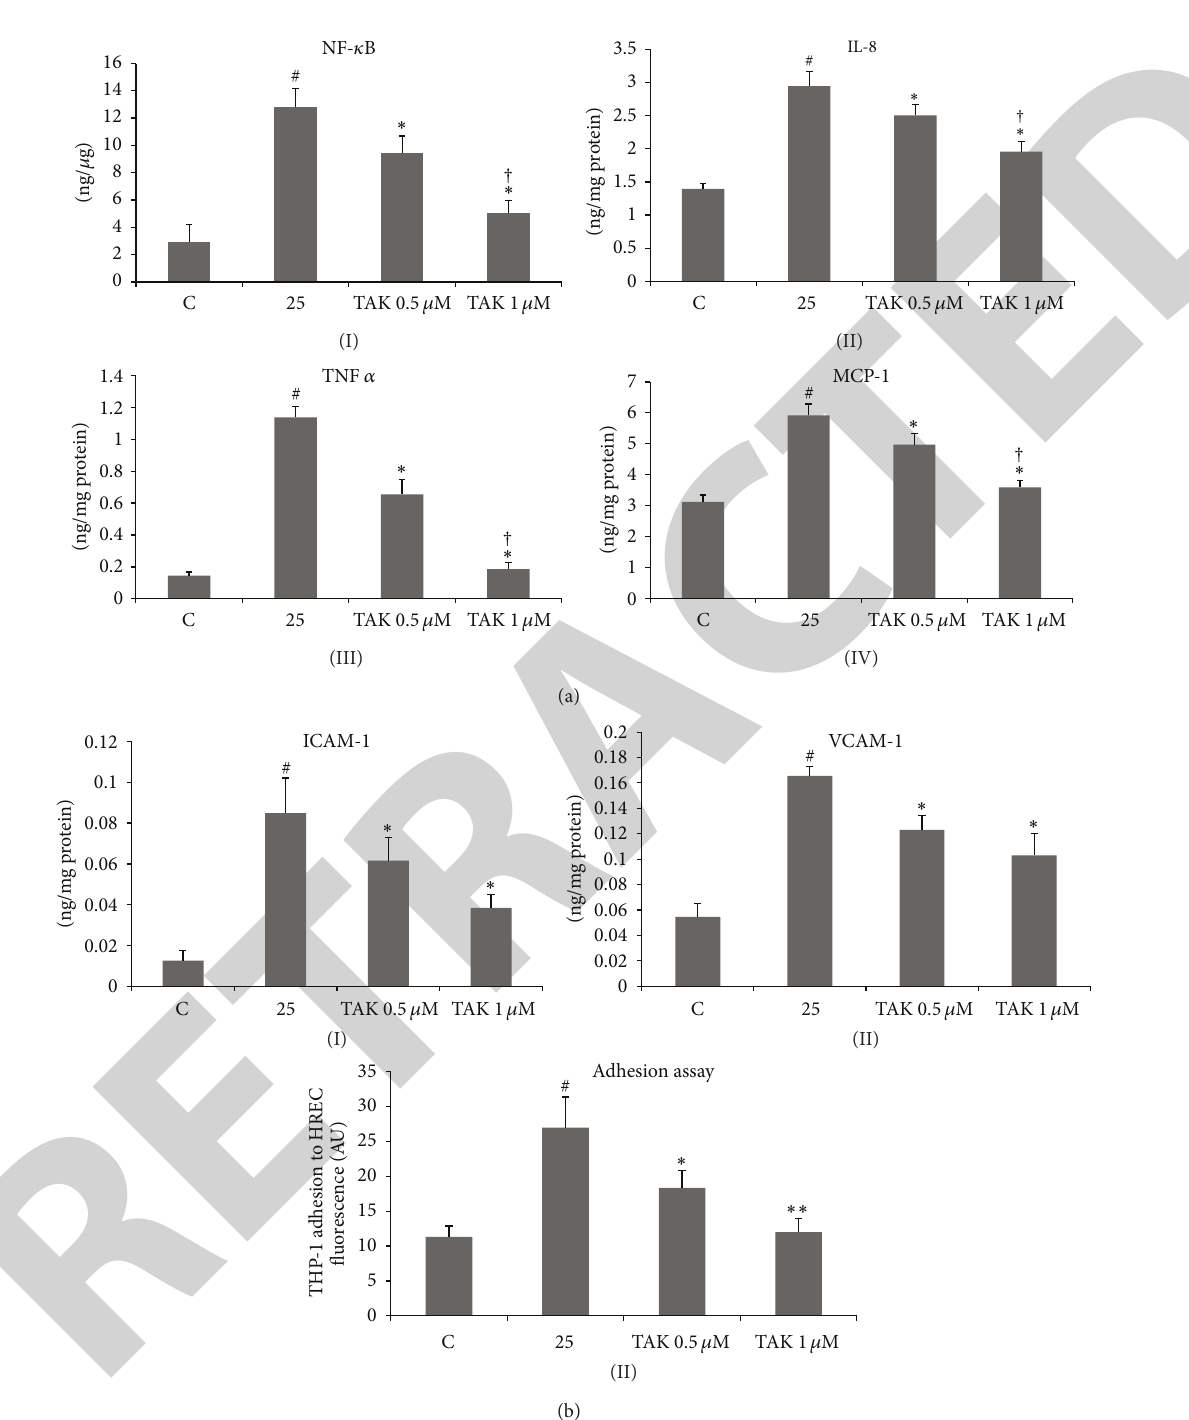
Figure 5: (a) TLR-4 inhibition by TAK 242 attenuates downstream inflammatory biomediators: HMVRECs were serum starved for 2 hours and treated with 0.5 and 1 𝜇 M TAK-242 for 2 hours. Thereafter 5.5 and 25 mM glucose treatments were performed as described in Figure 3. (I) NF- 𝜅 B, (II) IL-8, (III) TNF- 𝛼 , and (IV) MCP-1 levels are significantly decreased upon TLR-4 inhibition compared to HG treatment. # 𝑃 < 0.001 versus control, ∗ 𝑃 < 0.001 versus 25 mM, and † 𝑃 < 0.01 versus 0.5 𝜇 M TAK242. (b) Cell adhesion molecules ICAM-1 and VCAM-1 attenuation upon TAK 242 treatment. HMVRECs were serum starved for 2 hours and treated with 0.5 and 1 𝜇 M TAK-242 for 2 hours. Thereafter 5.5 and 25 mM glucose treatments were performed as described in Figure 4. Adhesion molecules (I) ICAM-1 and (II) VCAM-1 levels are significantly decreased upon TAK242 treatment. # 𝑃 < 0.001 versus control and ∗ 𝑃 < 0.001 versus 25 mM. (III) Adhesion assay showing decreased cell adhesion with TLR-4 inhibition. # 𝑃 < 0.001 versus control, ∗ 𝑃 < 0.01 versus 25 mM, and ∗∗ 𝑃 < 0.001 versus 25